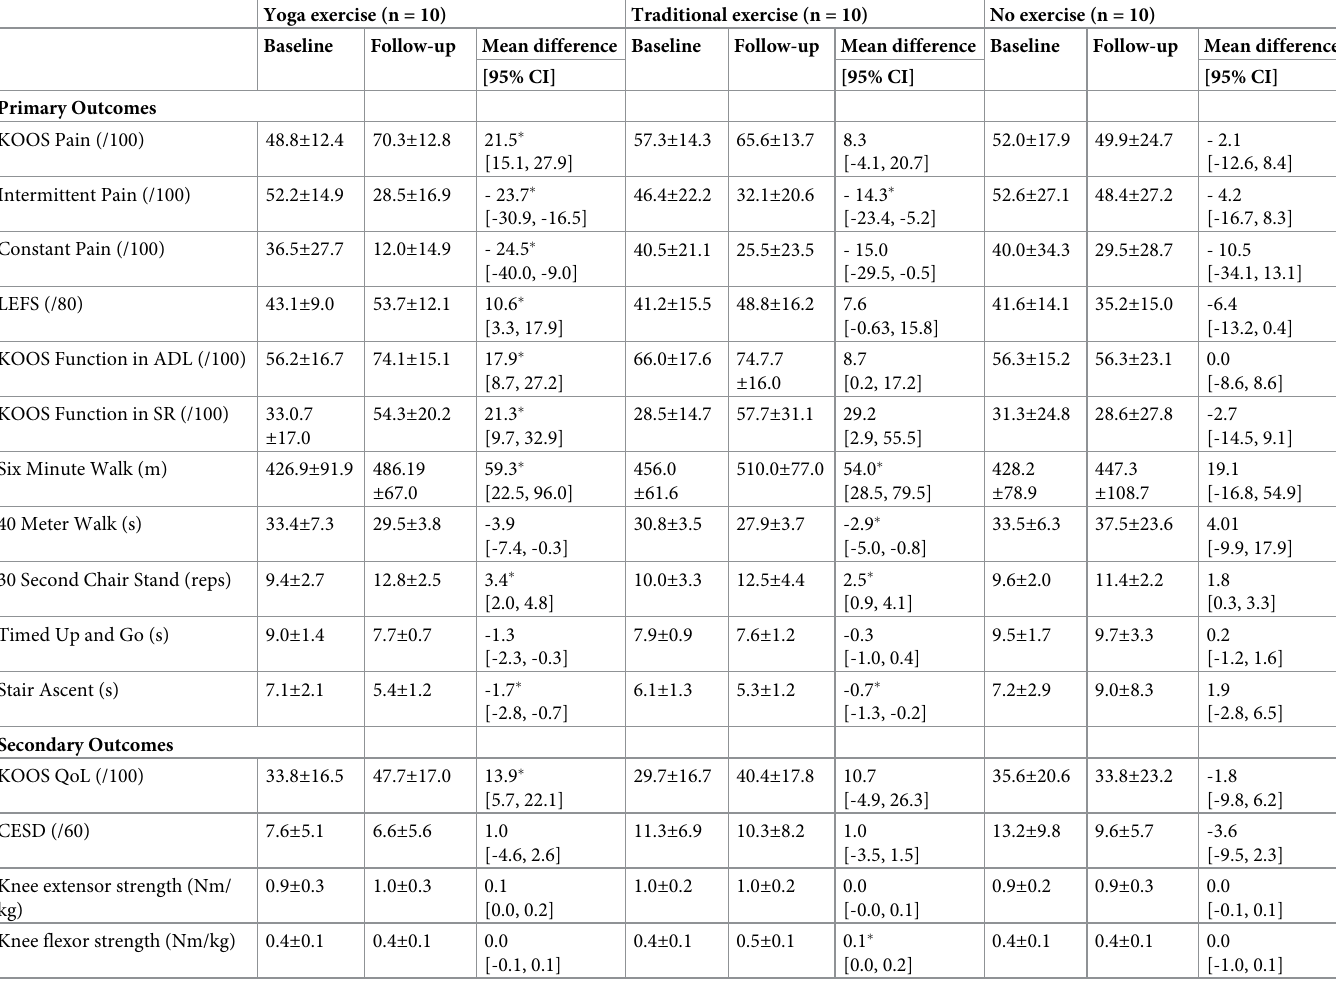
Table 3. Within-group differences in outcome measures. Baseline and follow-up group means ± standard deviations are presented with mean differences (follow-up minus baseline) and 95% confidence intervals